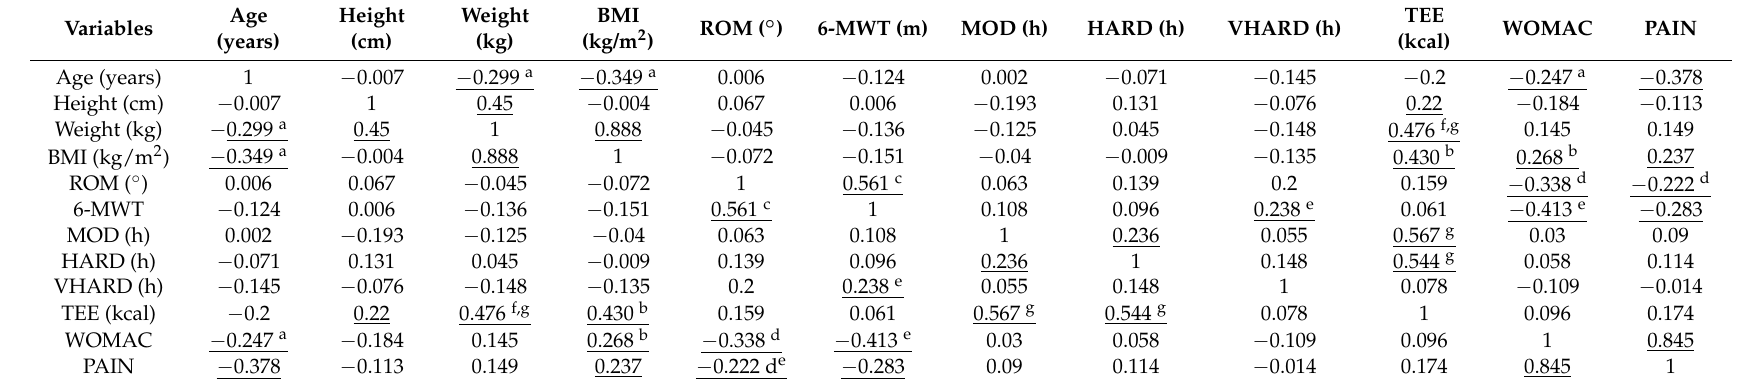
Table 3. Pearson product-moment correlations between dependent variables ( n =